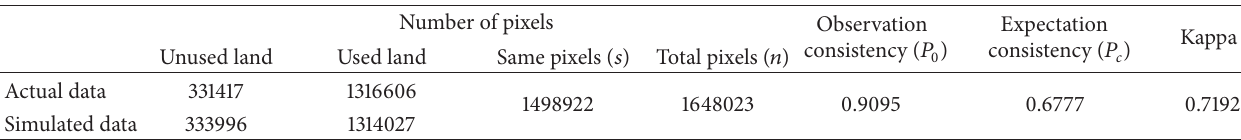
Table 8: Kappa coefficient of unused